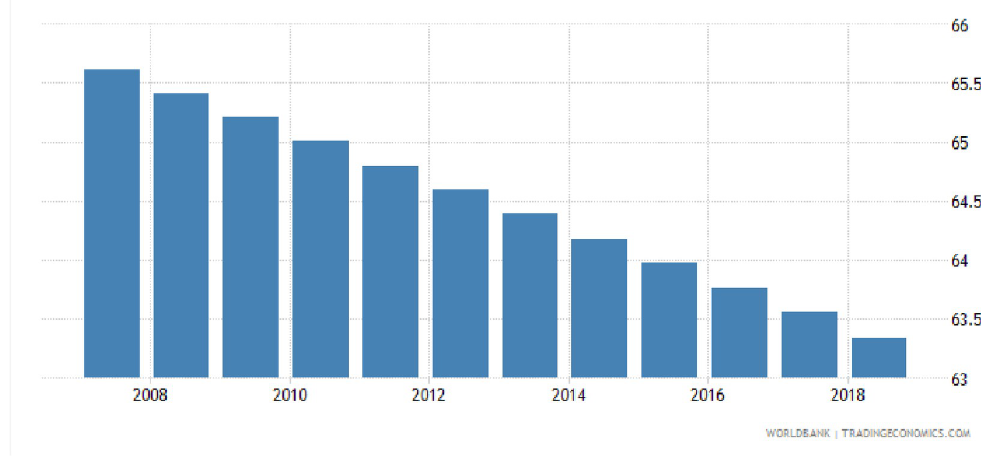
Fig 4. Trend of rural population in